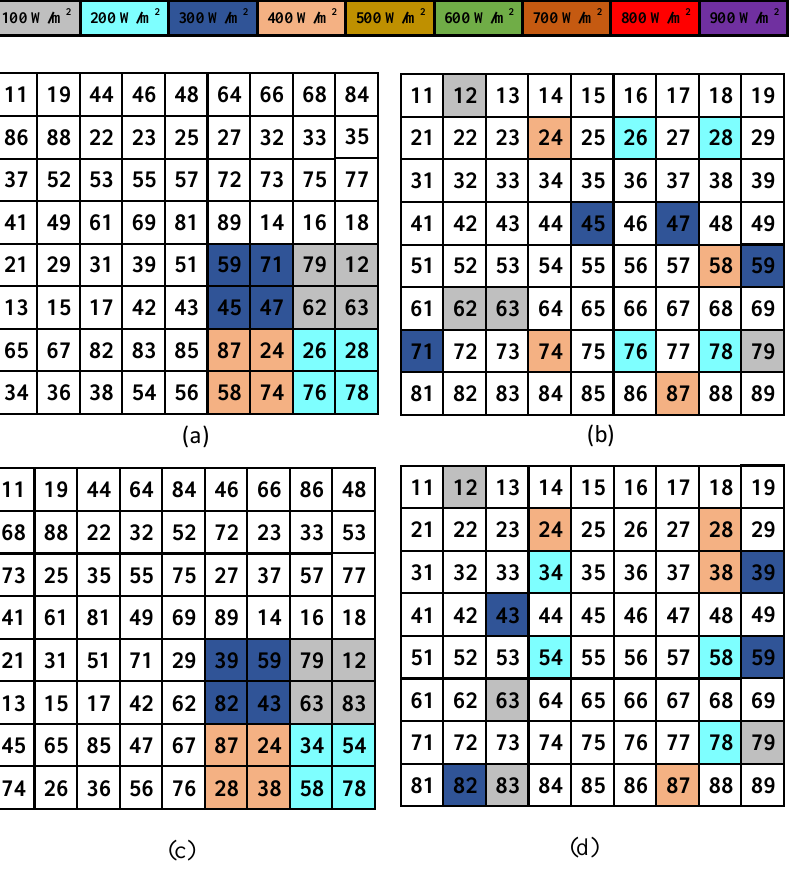
Figure 22. ( a ) OEP; ( b ) shade dispersion of OEP; ( c ) IOEP; and ( d ) shade dispersion of IOEP for 8 × 9 PV array at Bottom-Right PSC. The voltage–power characteristics of case-IV (Bottom-Right) are shown in the Figure 23. From the voltage–power characteristics it understood that IOEP reconfiguration has supe- rior performance under partial-shading conditions.